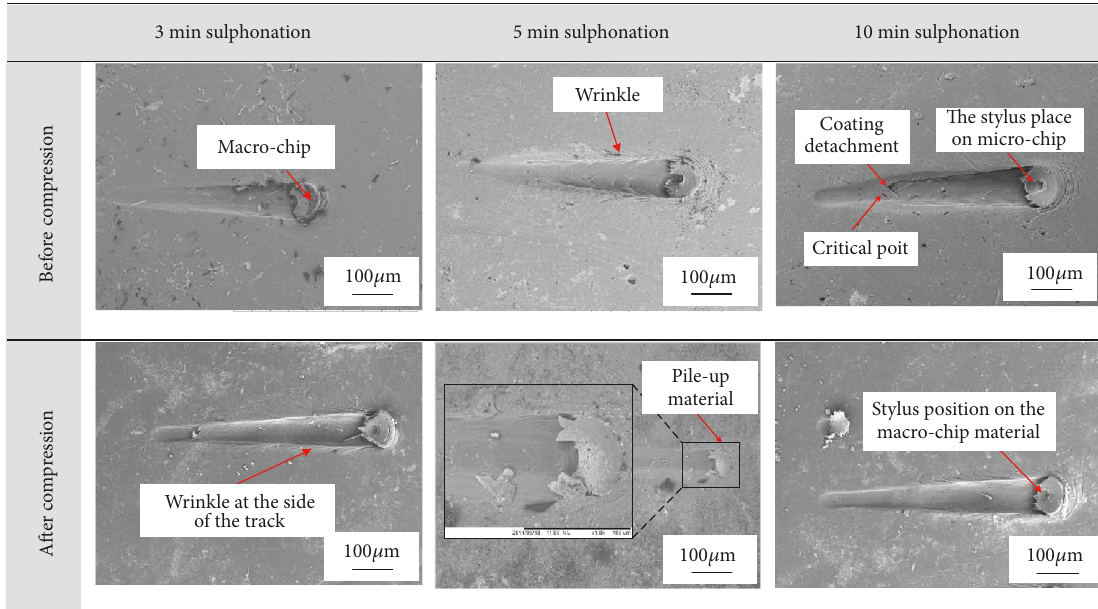
Figure 4: Scratch track images on the surface of the treated layer.